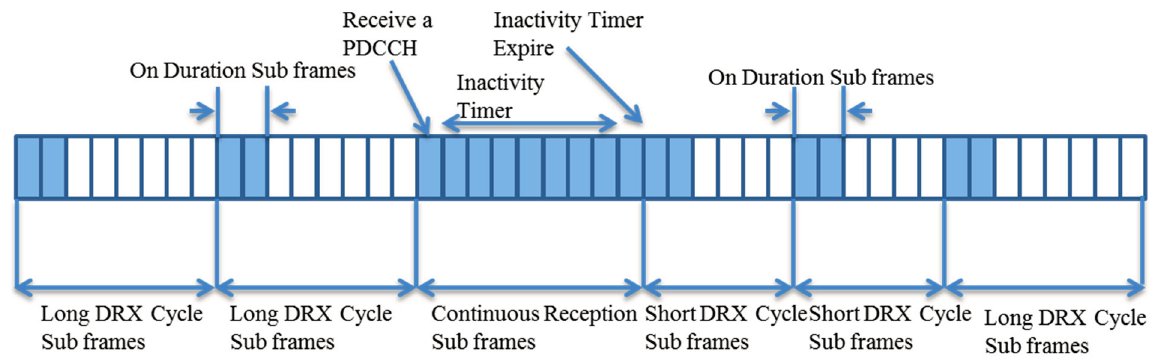
Figure 4. A basic 3GPP DRX